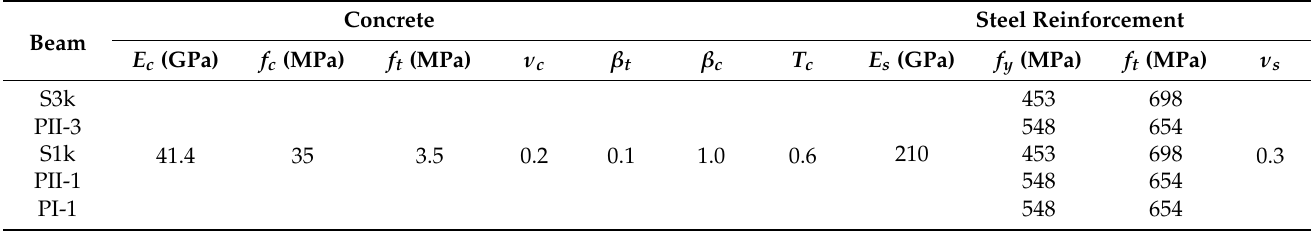
Table 4. Materials parameters of the constitutive models for concrete and for steel reinforcement.